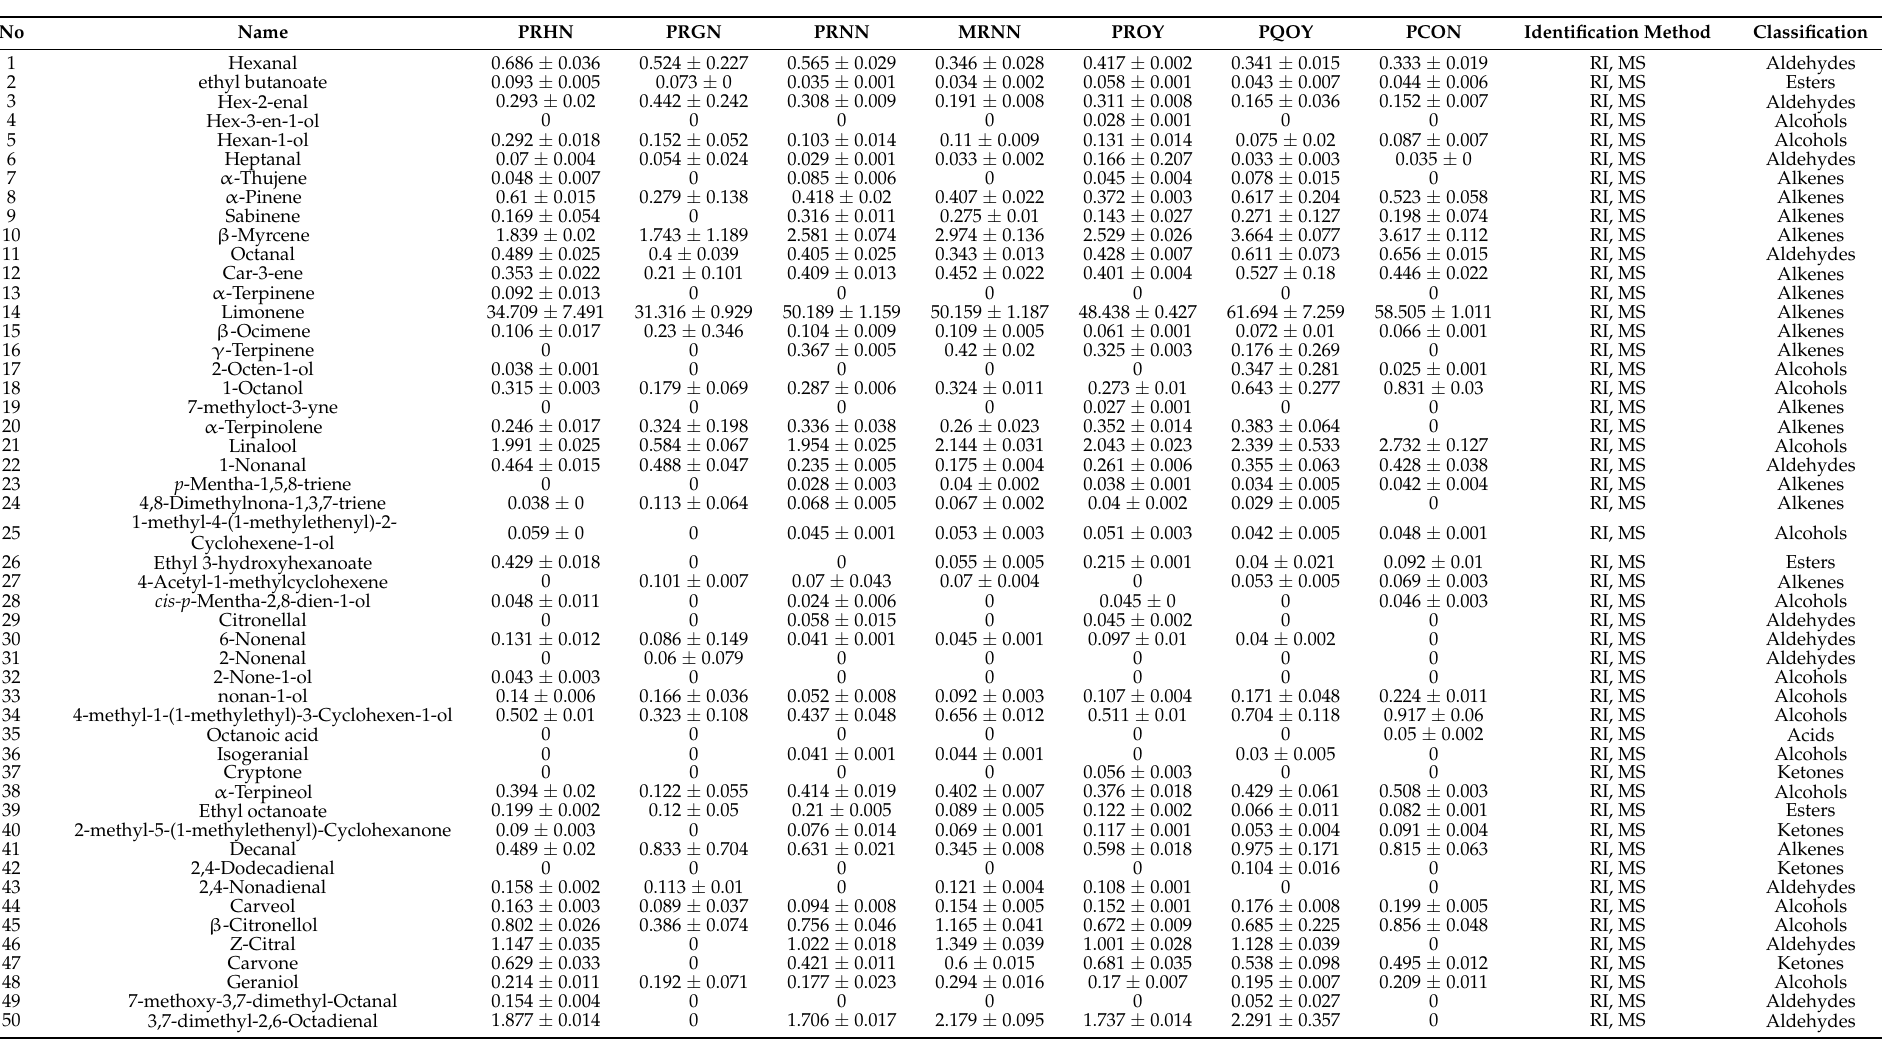
Table 1. The composition and relative contents of volatile organic compounds (VOCs) among Citrus sinensis